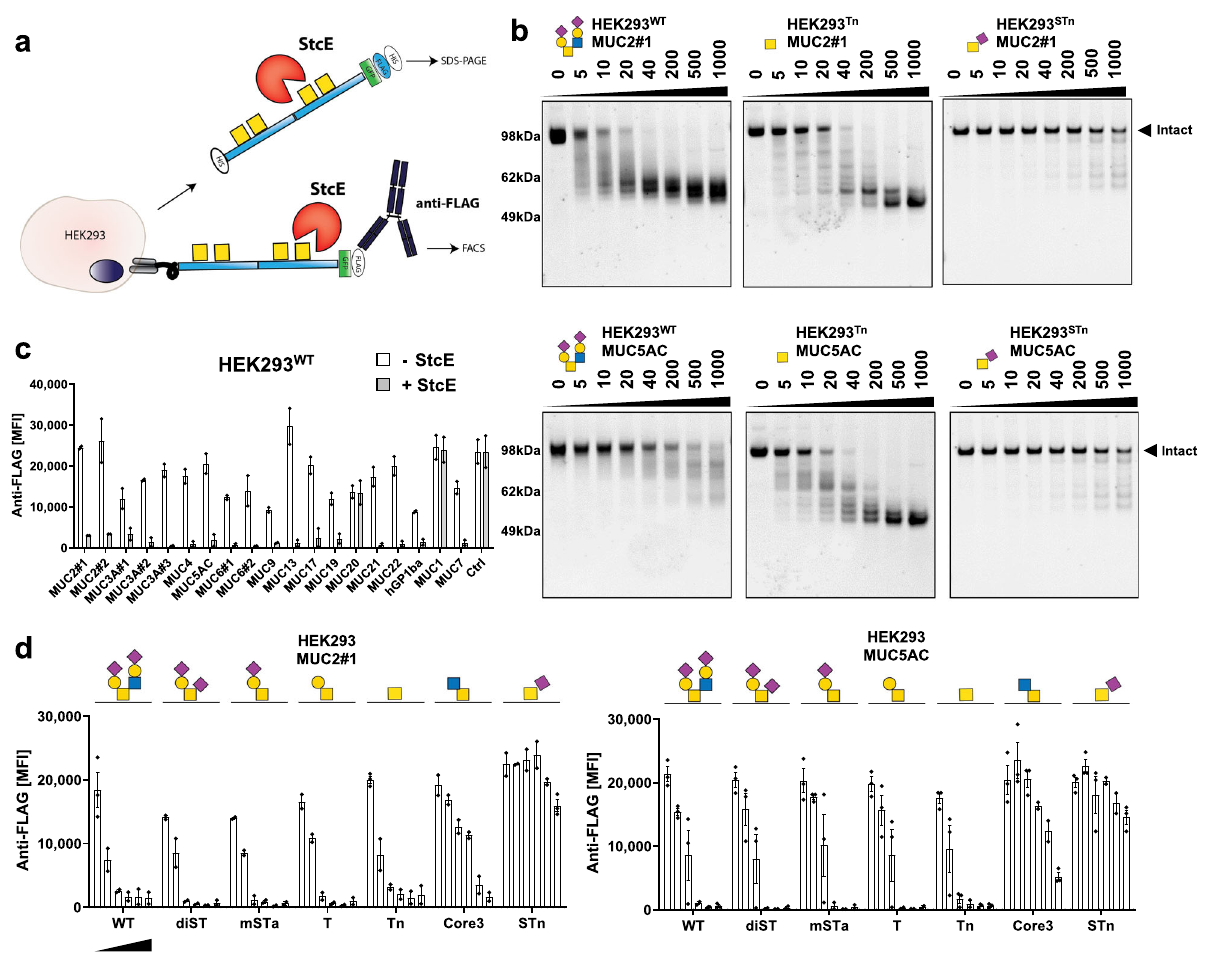
Fig. 5 The glycoprotease StcE cleaves selective mucin TRs and O-glycoforms. a Graphic depiction of the assay designs for enzyme assays with isolated and cell membrane-bound mucin TR reporters. b SDS-PAGE analysis of StcE digestion (dose titration) of isolated MUC2#1 and MUC5AC reporters produced in glycoengineered HEK293 cells (WT, Tn, and STn O-glycoforms). Puri fi ed reporters (0.5 µ g) were incubated for 2 h at 37 °C, and gels visualized with Krypton fl uorescent protein stain. Representative gels of three independent experiments are shown. c Flow cytometry analysis of StcE cleavage of different TR reporters expressed stably as membrane-bound proteins on the surface of HEK293 WT cells and detected by anti-FLAG antibody binding. Bar diagram shows average mean fl uorescent intensities (MFI) ± SEM. An arti fi cially designed TR reporter with a single O-glycosite was used to serve as a control (ctrl) for the clusters and patterns of O-glycans found in human mucin TRs. Data from three independent experiments are shown. d Flow cytometry analysis of StcE cleavage (0 – 1000 ng/mL dose titration) of MUC2#1 and MUC5AC membrane reporters stably expressed on glycoengineered HEK293 cells (core2, dST, mSTa, T, Tn, core3, and STn glycoforms). Note that core3 is represented as the core disaccharide (GlcNAc α 1-3GalNAc α 1-O-Ser/ Thr), but this is likely galactosylated and sialylated. Data are presented as average MFI ± SEM of three independent experiments. Source data are provided as a Source Data fi